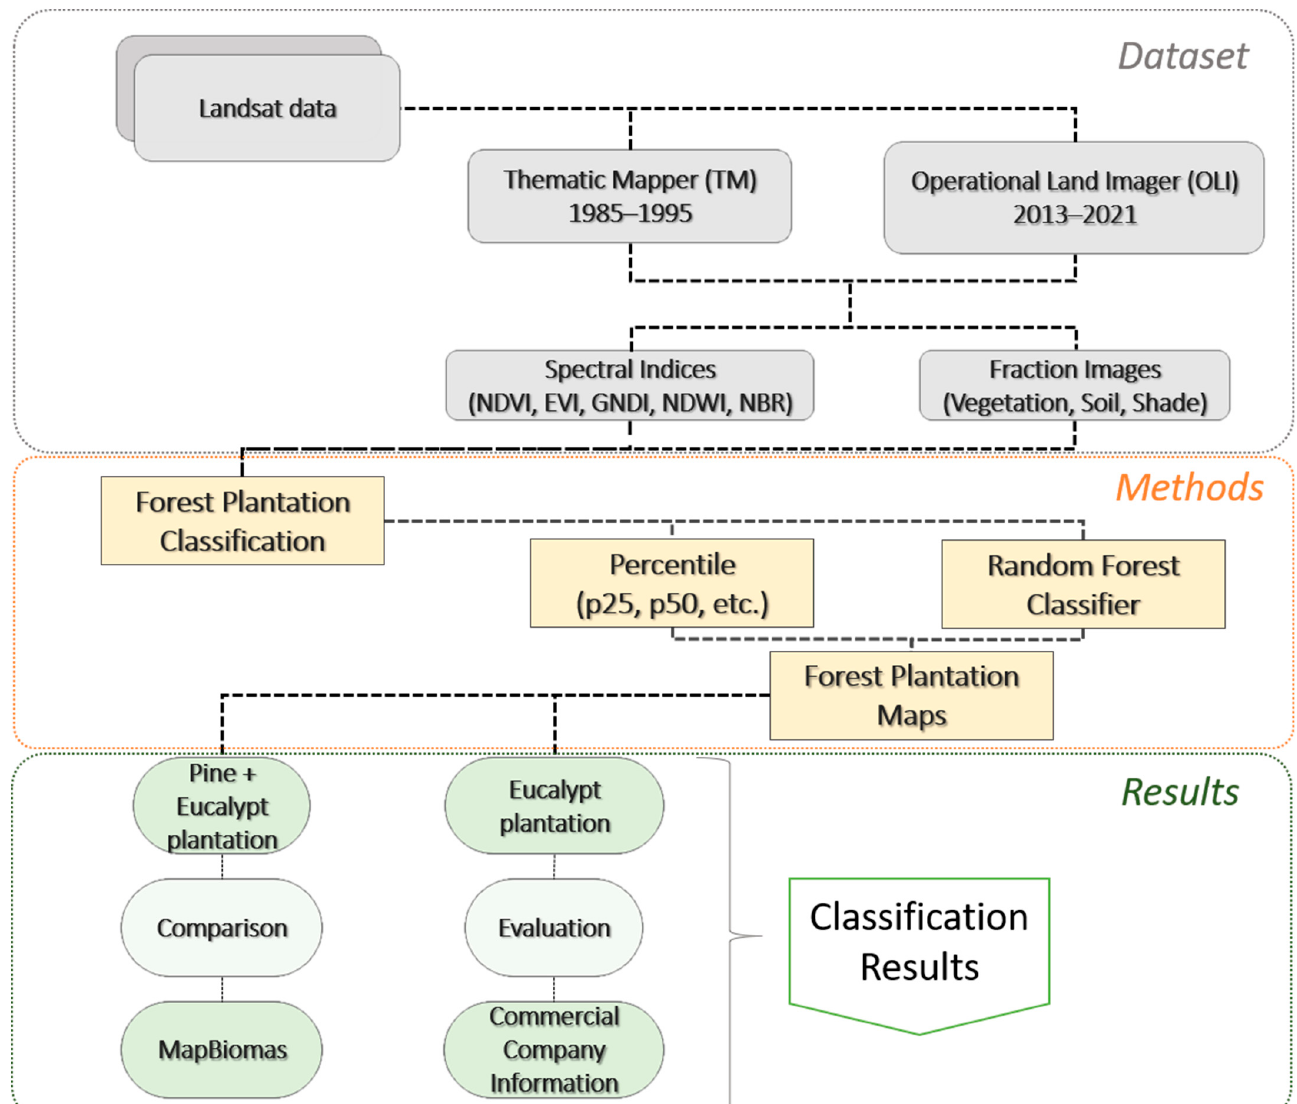
Figure 4. Flowchart of the methodological approach.